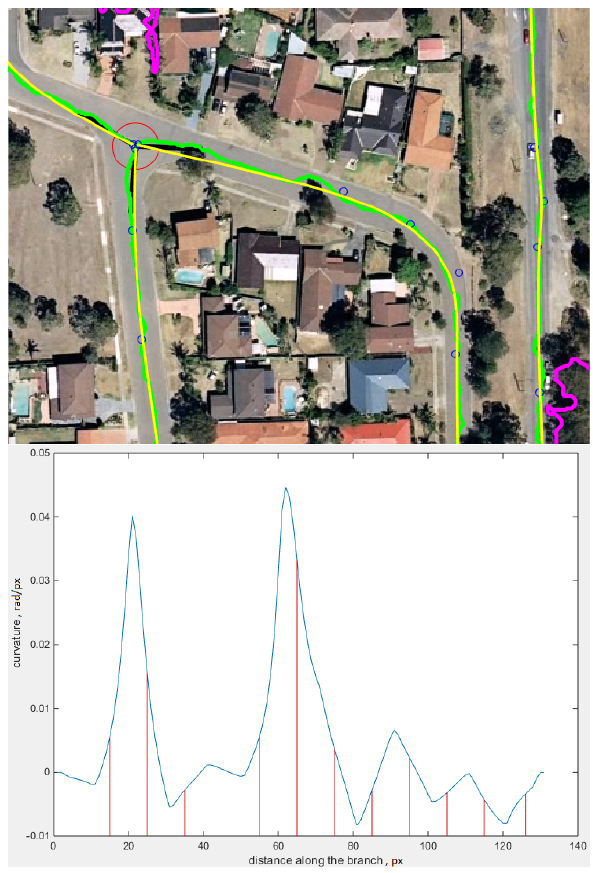
Figure 6: (top) Road branch points generated by thinning (green) are modelled with a spline (yellow); (bottom) curvature of the road branch with locations of the nodes shown in red the amount of information with which the feature is encoded and therefore are preferable for feature matching and data